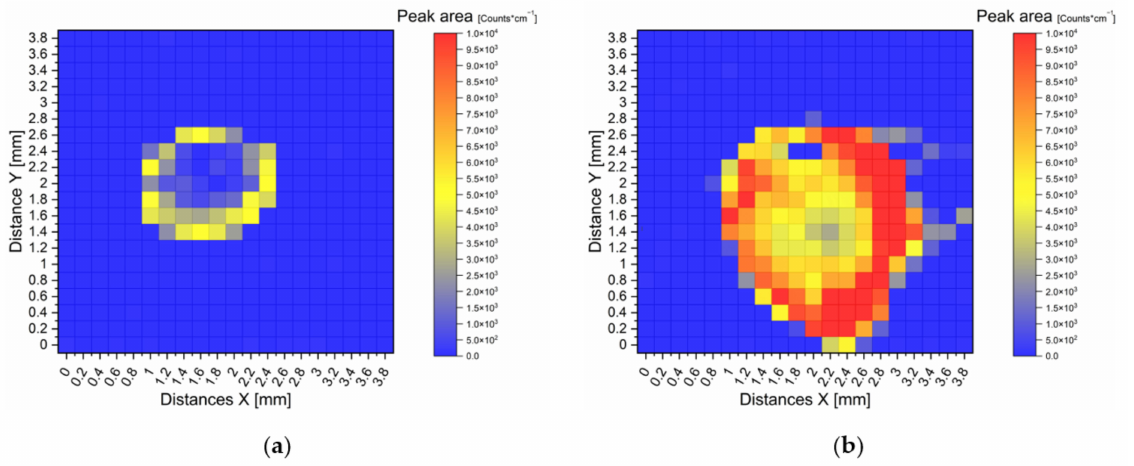
Figure 9. Heat map representations of Raman mappings on two SERS substrates. The peak area of the R6G peak at 1200 cm − 1 was evaluated. The spectral area within the grey column of Figure 6 was used for integration. The substrates were analysed with a 638 nm laser at 35 mW and 0.96 ng (2 µ L of 10 − 6 mol/L) R6G was applied by spiking a 2 µ L solution onto the substrates. ( a ) On the left side a SERS substrate with AuNPs on untreated aluminium and ( b ) on the right side AuNPs on sintered TiO 2